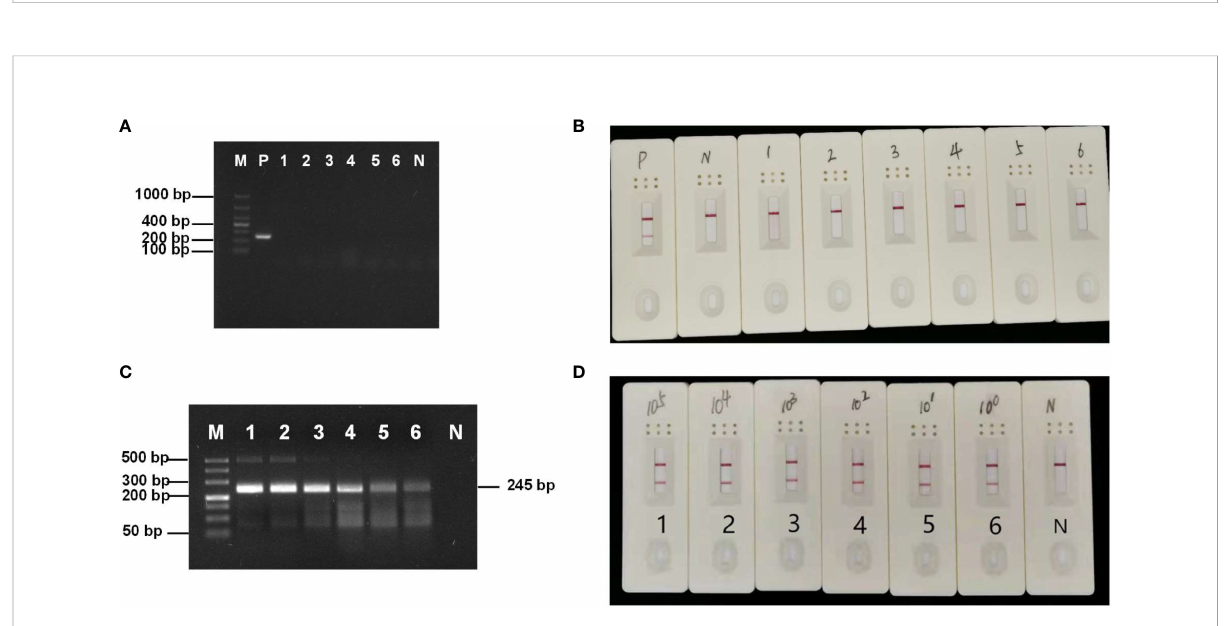
FIGURE 2 (A) Speci fi city of the RPA-AGE assay. M: DL 1000 Marker; P: Enterocytospora artemiae ; 1: Enterocytozoon hepatopenaei ; 2: Hepatospora eriocheir ; 3: Microsporidia sp.; 4: Metschnikowia bicuspidata ; 5: white spot syndrome virus; 6: Wicherhamomyces anomalus ; N: negative control. (B) Speci fi city of the RPA-LFD assay. P: Enterocytospora artemiae ; N: negative control; 1: Enterocytozoon hepatopenaei ; 2: Hepatospora eriocheir ; 3: Microsporidia sp.; 4: Metschnikowia bicuspidata ; 5: white spot syndrome virus; 6: Wicherhamomyces anomalus . (C) Sensitivity of RPA-AGE to gradient dilution of the recombinant plasmid. M: DL 500 Marker; N: negative control; 1: 4.7 × 10 5 copies/µL; 2: 4.7 × 10 4 copies/µL; 3: 4.7 × 10 3 copies/µL; 4: 4.7 × 10 2 copies/µL; 5: 4.7 × 10 copies/µL; 6: 4.7 copies/µL. (D) Sensitivity of RPA-LFD to gradient dilution of the recombinant plasmid. N: negative control; 1: 4.7 × 10 5 copies/µL; 2: 4.7 × 10 4 copies/µL; 3: 4.7 × 10 3 copies/µL; 4: 4.7 × 10 2 copies/µL; 5: 4.7 × 10 copies/µL; and 6: 4.7